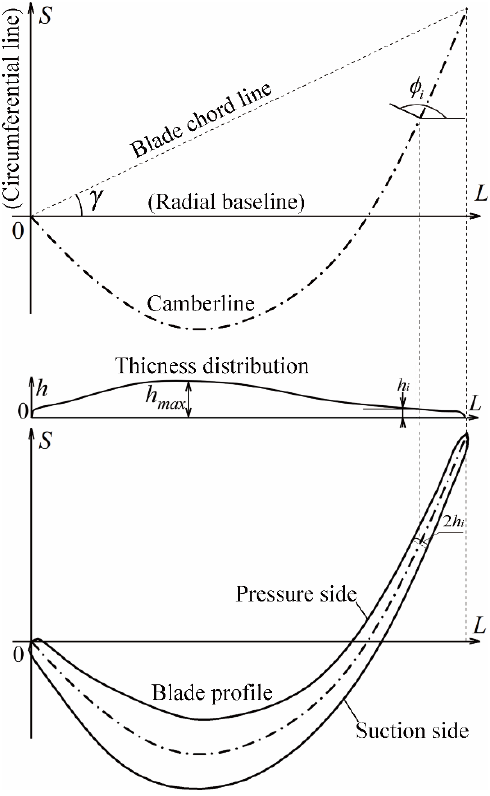
Figure 4. Blade profile layout.